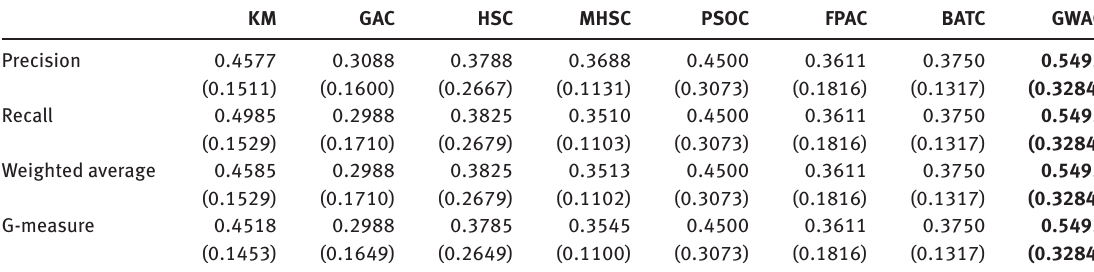
Table 3: Mean (SD) of Cluster Quality Matrices for Sph_4_3 Data